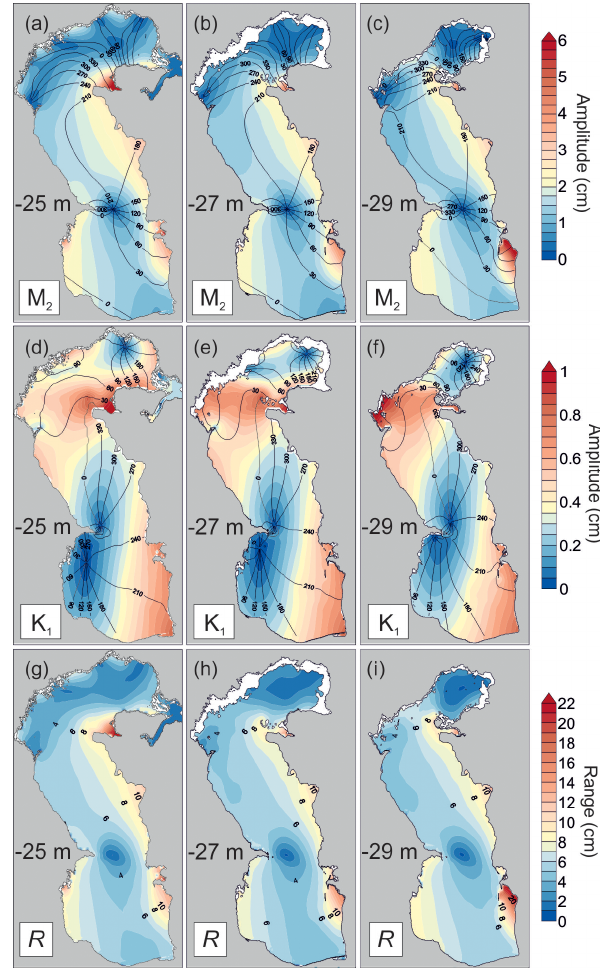
Figure 8. Tidal maps for the amplitude of the M 2 constituent (a, b, c) , K 1 (d, e, f) , and tidal range (g, h, i) with different MSL values for the Caspian Sea: − 25m (a, d, g) , − 27m (b, e, h) , − 29m (c, f, i)